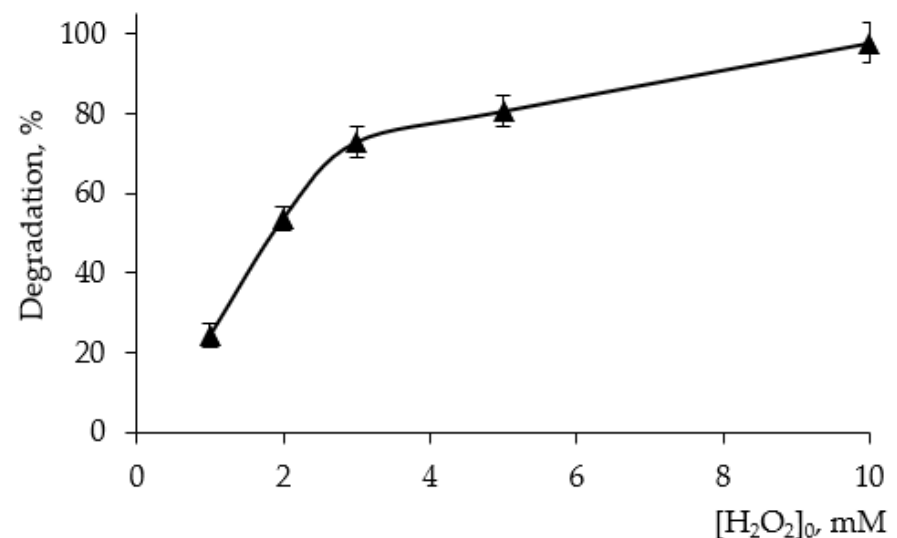
Figure 5. Effect of initial concentration of H 2 O 2 on the efficiency of 4-chlorophenol degradation under UVA LED irradiation (365 nm). [4-CP] 0 = 10 mg/L, exposure time = 1 h.